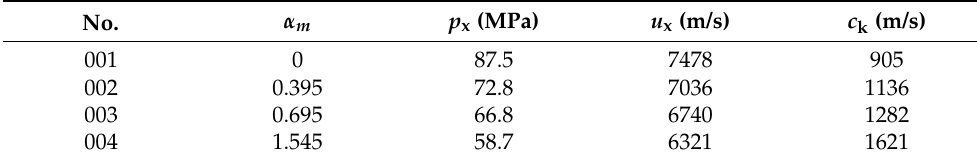
Table 1. Detailed parameters of the blast shock wave for different α m